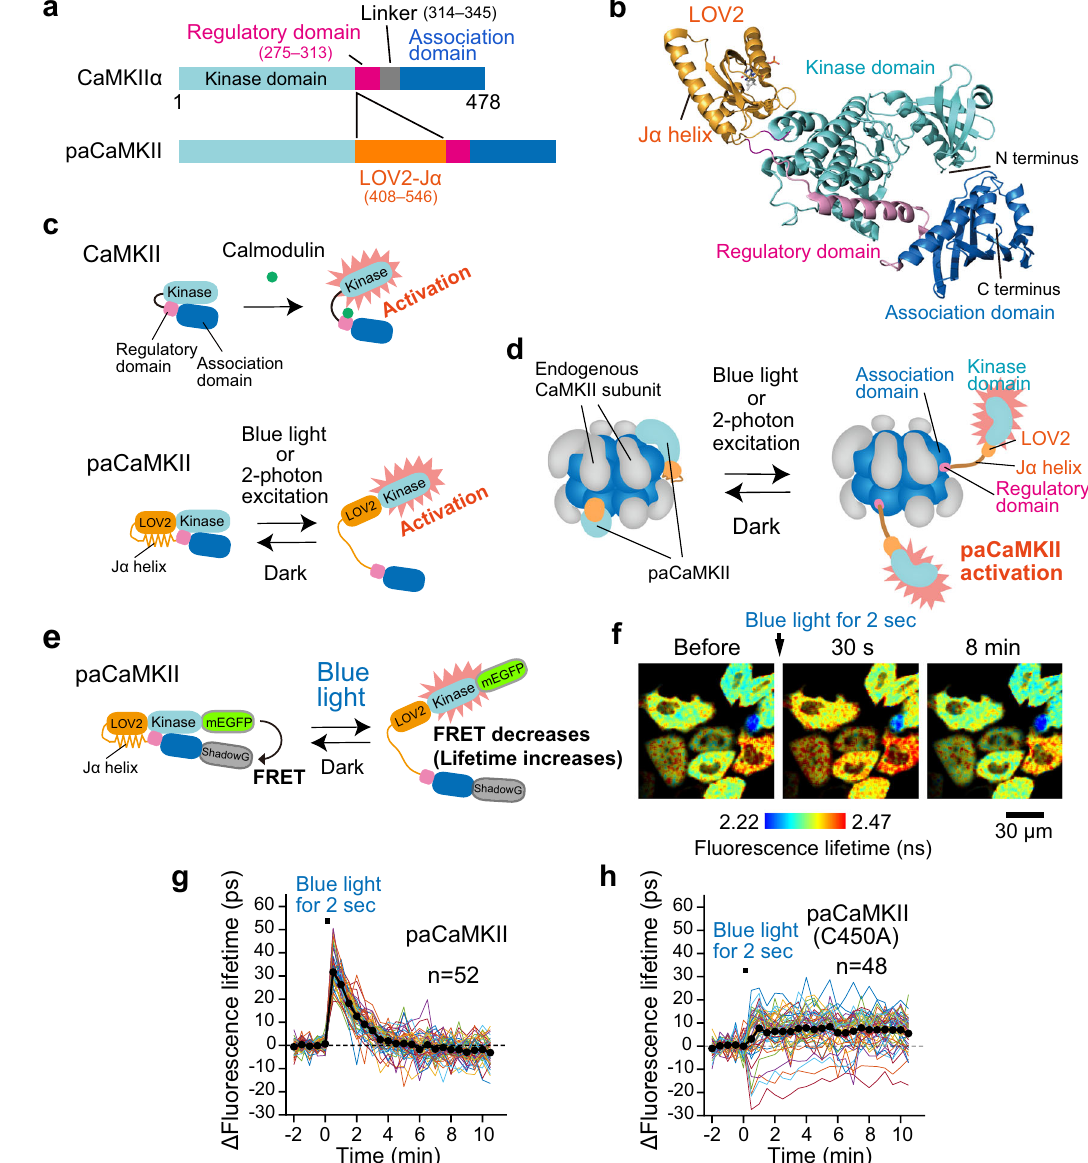
Fig. 1 Development of paCaMKII. a CaMKII α and paCaMKII domain structures. b Structural model of paCaMKII, visualized with PyMOL. The LOV2, kinase, regulatory, and association domains are shown as yellow-, cyan-, magenta-, blue-colored cartoons, respectively. Note that this structure is putative, and was created by available structural data (PDB: #3SOA and 2V1B) 34,35 . c Schematic drawing of endogenous and paCaMKII activation. d Schematic drawing of paCaMKII activation in the oligomeric state. Note that most CaMKII and paCaMKII likely exist in oligomeric form in cells. e A schematic of the conformational change of the paCaMKII FRET construct. mEGFP and ShadowG 66 were fused to the N- and C-terminus, respectively. Blue light illumination induces the structural change of paCaMKII (i.e., the distance between mEGFP and ShadowG becomes longer), leading to decreased FRET and increased mEGFP fl uorescence lifetime. f Representative fl uorescence lifetime images of mEGFP-paCaMKII-ShadowG after blue LED light illumination for 2 s at 35 mW cm − 2 . For imaging, two-photon excitation at 920 nm was used to excite mEGFP. The lifetime change (conformational change) of mEGFP- paCaMKII-ShadowG ( g ) and its light-insensitive mutant (C450A) ( h ) in individual HeLa cells after blue light illumination. Colored lines represent the response signal from individual cells, and the black circles indicate the average time course. The data are presented as mean ± SEM. The number of samples ( n ) is indicated in the respective panels. Source data are provided as a Source Data fi